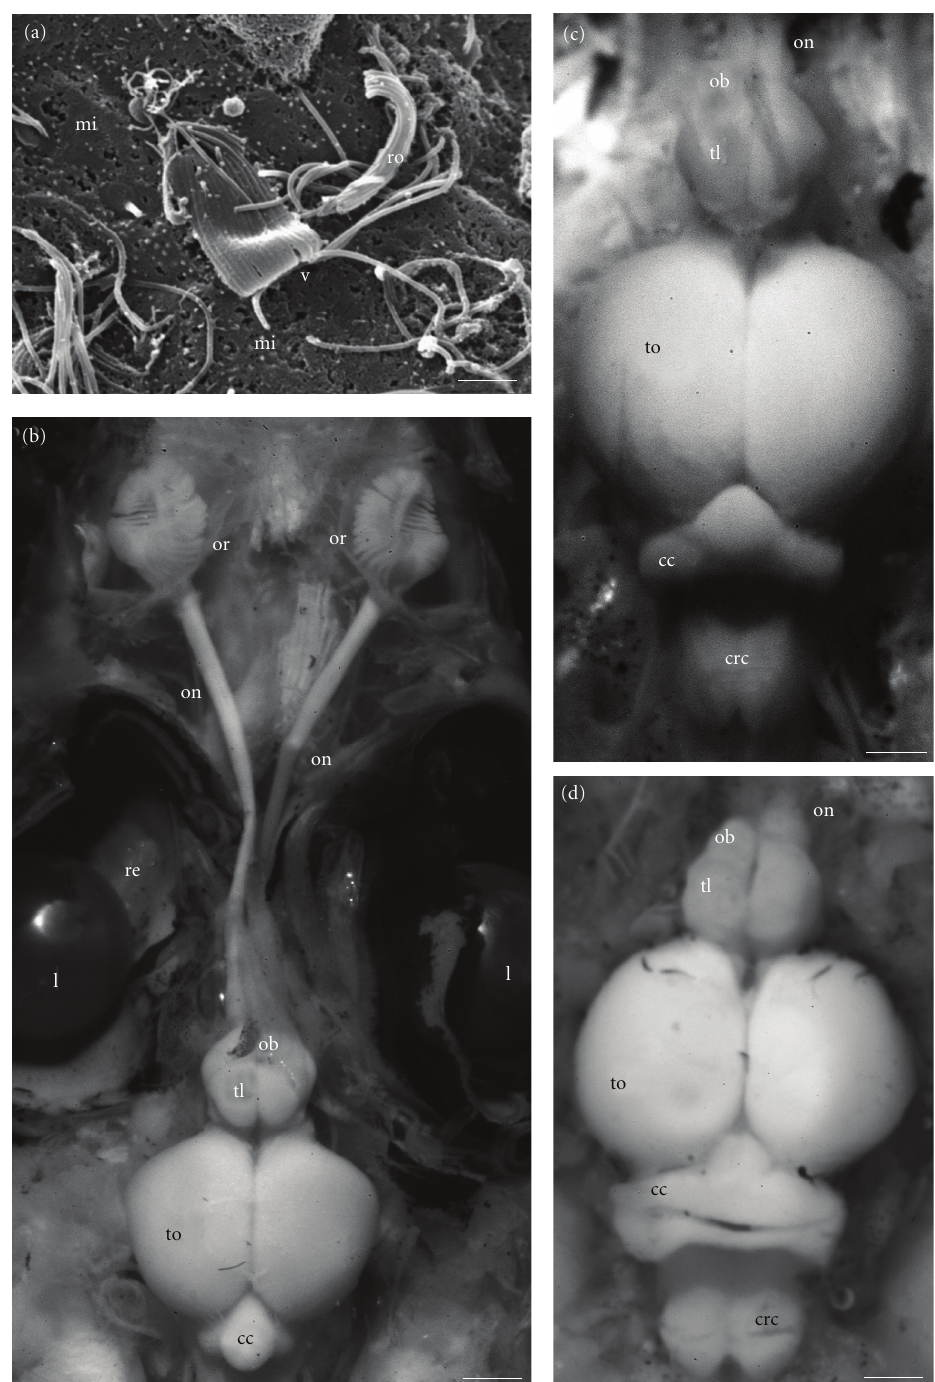
Figure 3: SEM of the brain and receptor cells. (a) Rod receptor and compound “vela” on lamellae of Trachinocephalus myops , scale bar = 2.5 μ m; (b) brain and olfactory rosettes of Saurida tumbil , scale bar = 3.5 mm; (c) brain of T. myops , scale bar = 1cm; (d) ibid of Synodus variegatus, scale bar = 1cm . cc, cerebellum ; crc, corpus cerebellis ; l, eye lens; mi, microvillar cells; ob, olfactory bulb; on, olfactory nerve; or, olfactory rosettes; re, retina (part); ro, rode-like compound cilia; tl, telencephalon ; to, optic tectum; v, “vela-like” compound